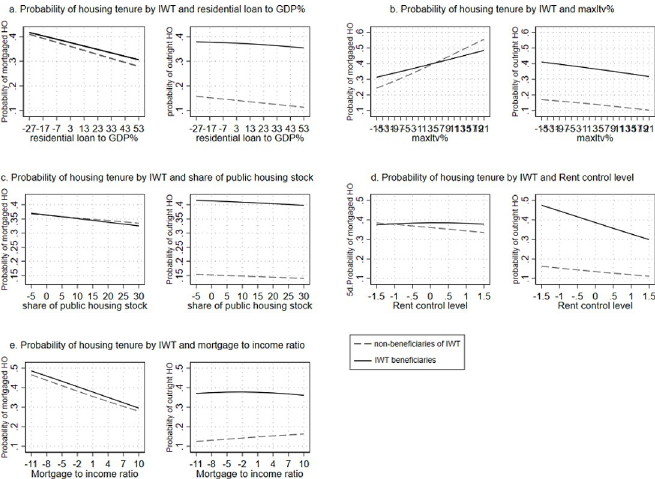
Fig 5. a-e. Predictive margins of pooled multinomial logistic regression predicting the difference in probability of housing tenure by IWT and macro variables (reference group: Non-homeownership) . Note: Macro variables are centered around the mean.